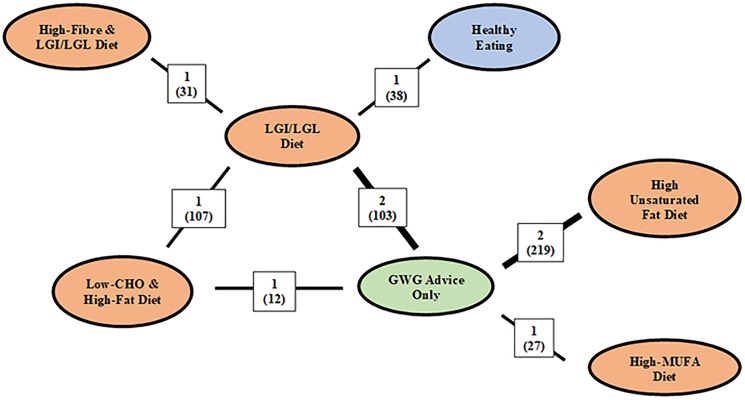
Network geometry of trials that provided GWG advice in both arms and reported fasting glucose.Abbreviations: CHO, carbohydrate; LGI, low-glycemic index; LGL, low-glycemic load; GWG, gestational weight gain; MUFA, monounsaturated fatty acids. The colors of each node correspond to a different diet class: orange node represents diets that targeted macronutrient intake, blue nodes represent diets that targeted overall healthy eating, and green nodes represent diets that targeted GWG. The numbers above each line joining two comparators correspond to the number of trials that compare the treatments with the number of included participants expressed in brackets. Thickness of line represent the number of studies included for that dietary comparison. Distances between nodes are not meaningful.